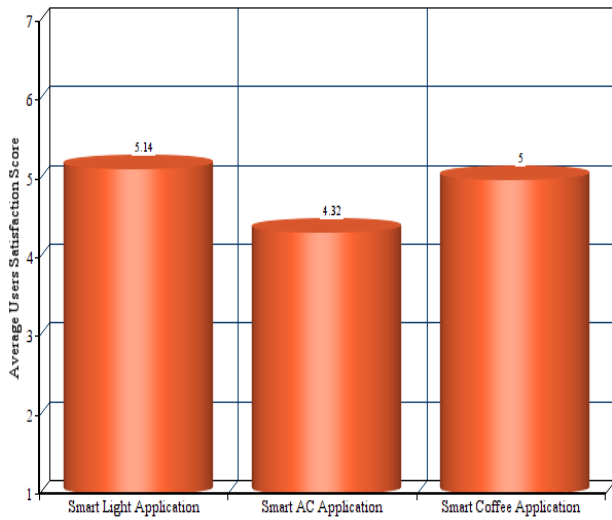
Figure 7. Users Satisfaction Score for Smart Home